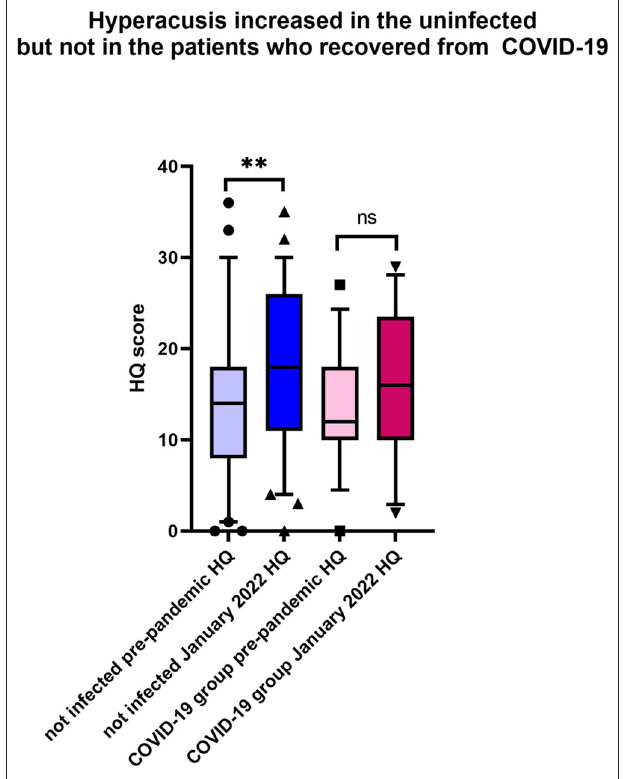
FIGURE 3 | During the pandemic, hyperacusis increased in the uninfected tinnitus patients. Shown is the box & whiskers plot (5–95 percentile), Wilcoxon paired test ( ** p < 0.0001; ns, not